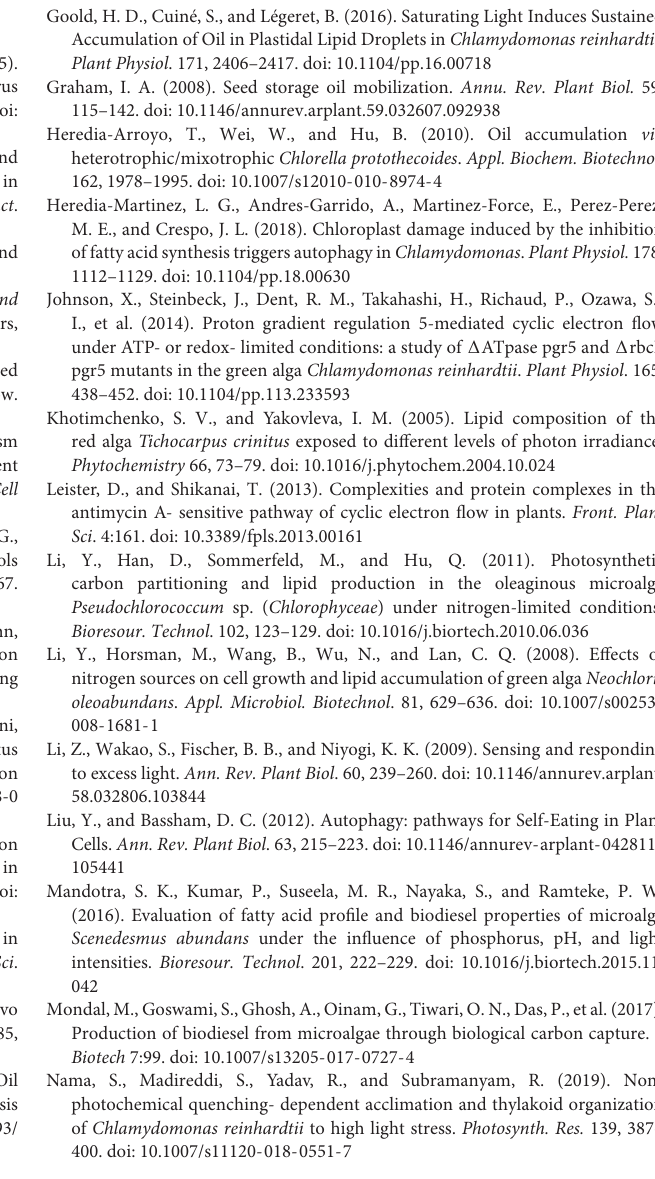
Supplementary Figure 3 | Neutral lipid content is quantified from the cells grown under normal and high light. Neutral lipid content was qualitatively measured with Nile Red fluorescence from the cells WT , pgrl1 , and pgr5 grown with normal (50 µ mol photons m − 2 S − 1 ) and high (500 µ mol photons m − 2 S − 1 ) light condition stained with Nile Red on days 1–4. The measurements have been done with a microplate reader. Three biological experiments were done ( n = 3). In ‘ x ’ axis WT, pgrl1 and pgr5 50; WT, pgrl1 and pgr5 500, represents 50 and 500 µ mol photons m − 2 s − 1 . Statistical significance was analyzed using one-way ANOVA, and subsequent Tukey’s post hoc t- test and p -value obtained are indicated ( ∗∗∗ p < 0.001). Supplementary Figure 4 | Ultrastructure analysis of C. reinhardtii cells during normal (50 µ mol photons m − 2 s − 1 ) and high light (500 µ mol photons m − 2 s − 1 ). Transmission electron micrographs of C. reinhardtii cells WT and mutants pgrl1 and pgr5 grown under photoheterotrophic conditions under 50 µ mol photons m − 2 s − 1 and 500 µ mol photons m − 2 s − 1 . Representative images were taken